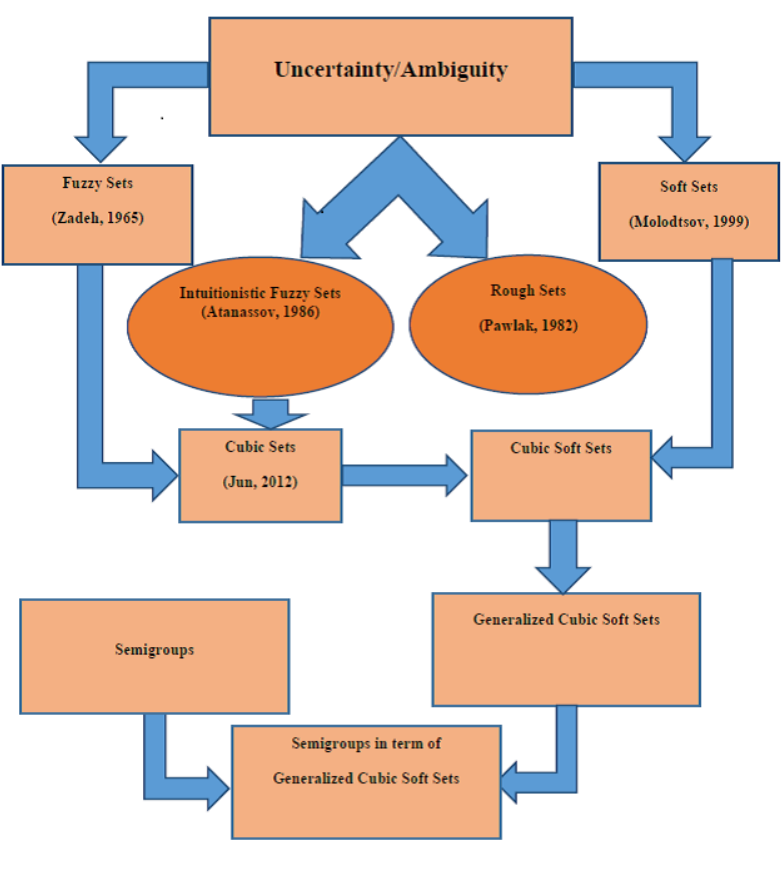
Figure 1. Interdependence of